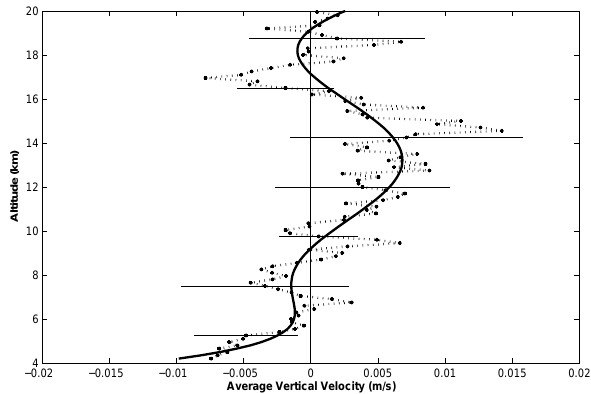
Fig. 2. Height profile of mean vertical wind W measured by the VHF radar at Gadanki (solid line represents polynomial fit of 6th order; dotted line represents actual